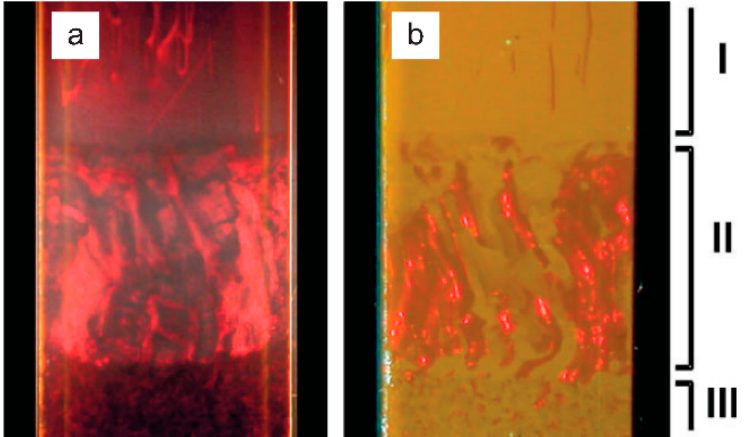
Figure 5. Capillary tube containing phase-separated goethite dispersions (16% volume fraction) displaying three distinctly different regions in addition to an isotropic region higher in the capillary (not shown). Images are taken using ( a ) transmitted light between crossed polarizers: Schlieren patterns typical for a nematic phase are observed in region I. ( b ) Reflected light: bright red Bragg reflections from a smectic phase are seen in region II. The columnar phase (predominant in region III) is not distinguished by special optical characteristics. Reprinted with permission from Vroege, G.J.;